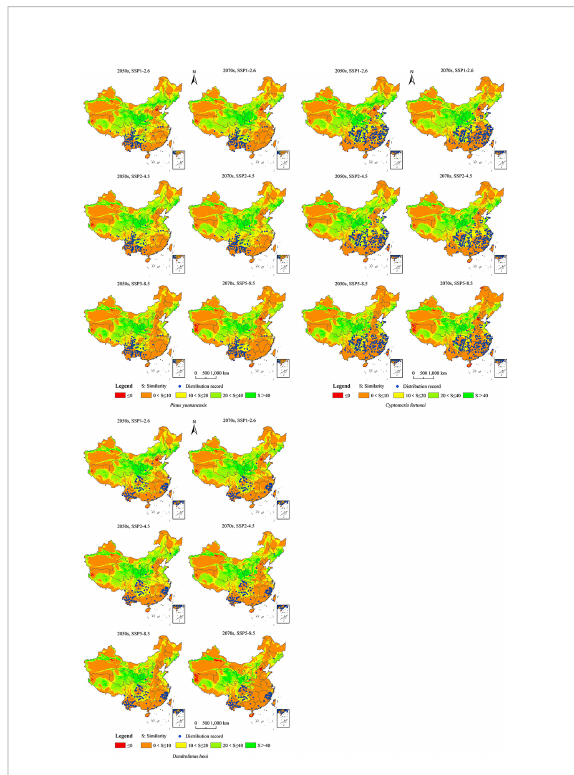
FIGURE 7 MESS maps for possible distribution areas of P. yunnanensis , C. fortunei , and D. houi under scenarios of future climate